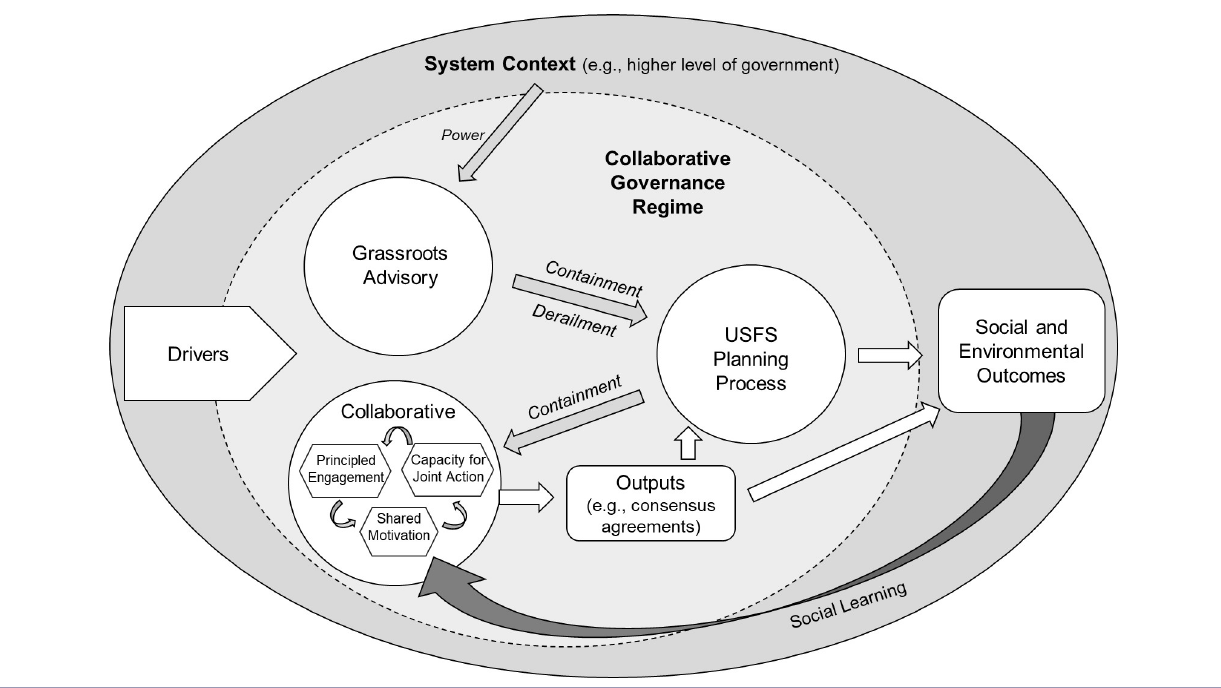
Fig. 3. Conceptual framework of the collaborative governance regime. Adapted from Emerson and Nabatchi